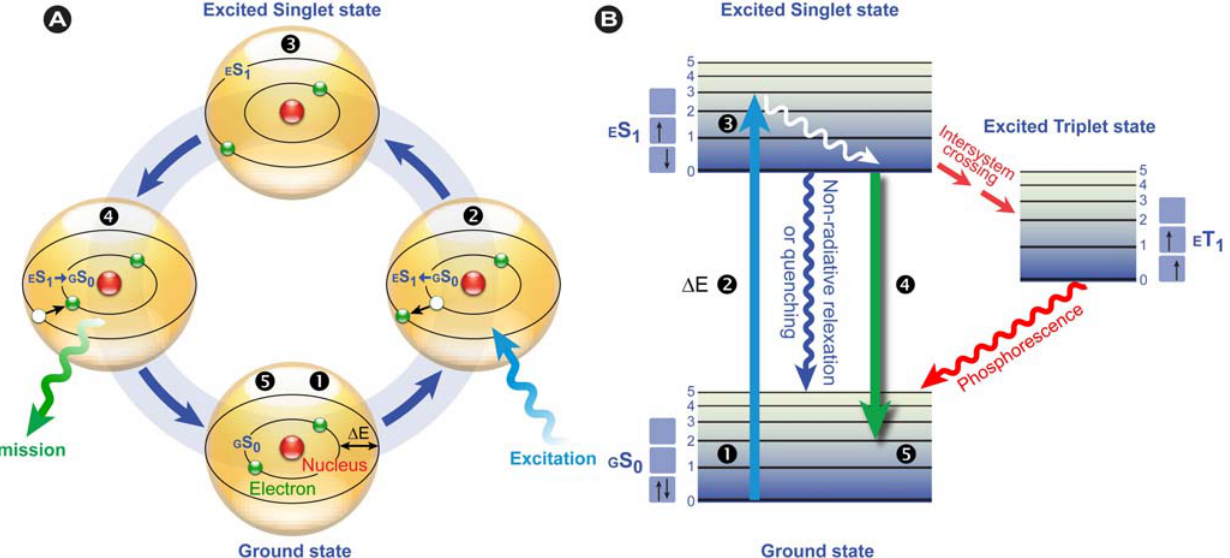
Figure 2. Fluorescence principle. ( A ) Schematic representation of the fluorescence  , absorption of a phenomenon in the classical Bohr model. From the ground state G S 0 light quantum (blue) causes an electron to move to a higher energy level    . After residing in this “excited state”  for a particular time, the fluorescence lifetime, the electron falls back to its original level    and the fluorochrome dissipates the excess energy by emitting a photon (green)  . ( B ) Jab ł o ń ski diagram: Upon photon absorption, a electron (electronic singlet) is promoted to a higher and excited state, ground state G S 0 relaxes quickly to a lower vibrational excited state (white line) and thereby looses energy. When returning to the ground state, it dissipates the remaining energy by emitting a photon with a longer wavelength, i.e. , fluorescence emission. The spins of electrons in the singlet states (paired or unpaired anti-parallel spins) compared to the triplet state (unpaired, → E T requires spin parallel spin) are depicted. Notice that intersystem crossing from E S 1 1 conversion and phosphorescence occurs through relaxation from the triplet excited